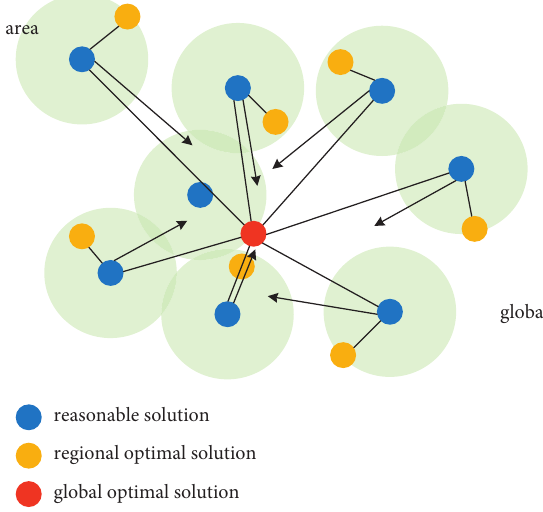
Figure 1: Particle swarm algorithm.